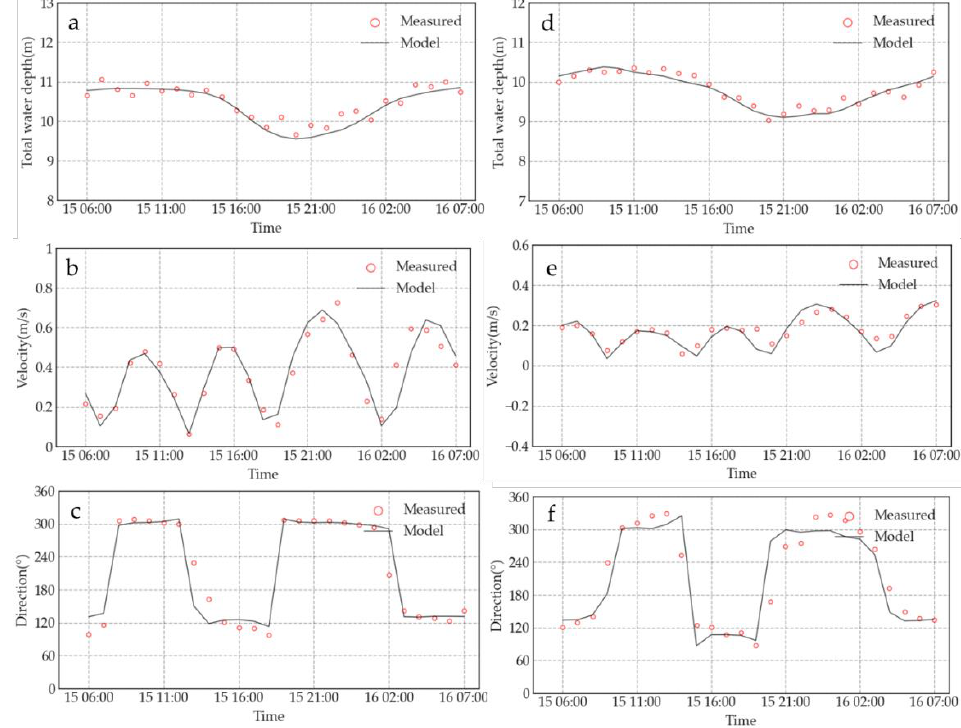
Figure 6. Model validation during calm weather period: water depth, wind speed, and direction at Dongying Port station ( a – c ) and Gudong Seawall ( e – f ).